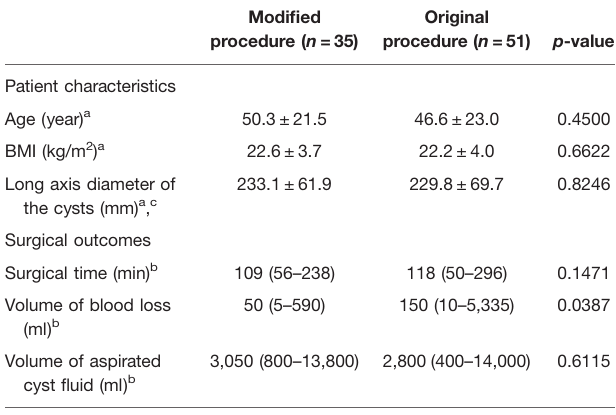
TABLE 1 | Patient characteristics and surgical outcomes.